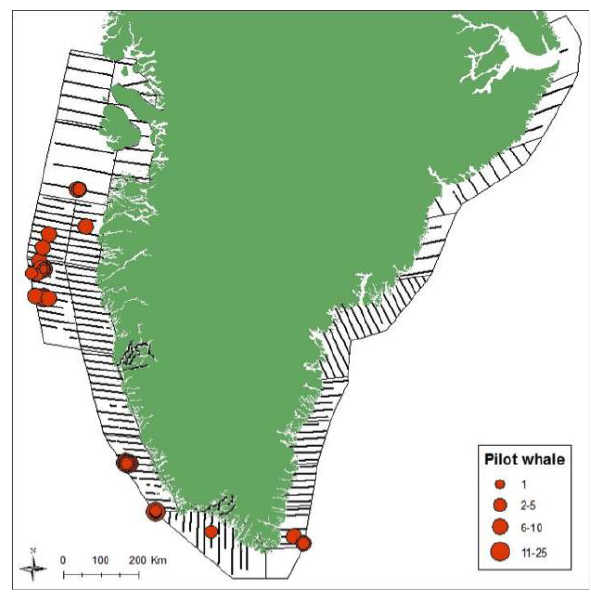
Figure 11. Survey effort in sea states <5 and sightings with group sizes of pilot whales in East and West Greenland.